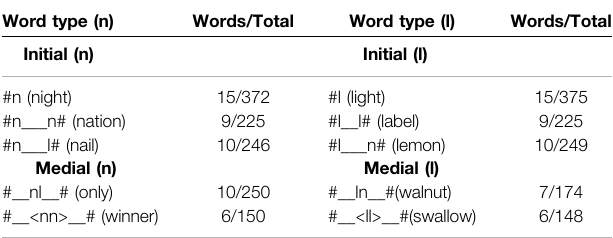
TABLE 2 | English word list numbers for initial and middle /l/ and /n/